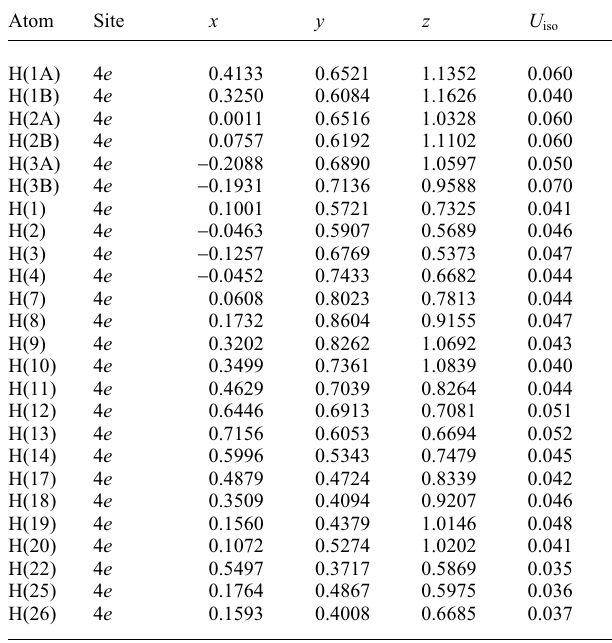
Table 2. Atomic coordinates and displacement parameters (in Å 2 ) .